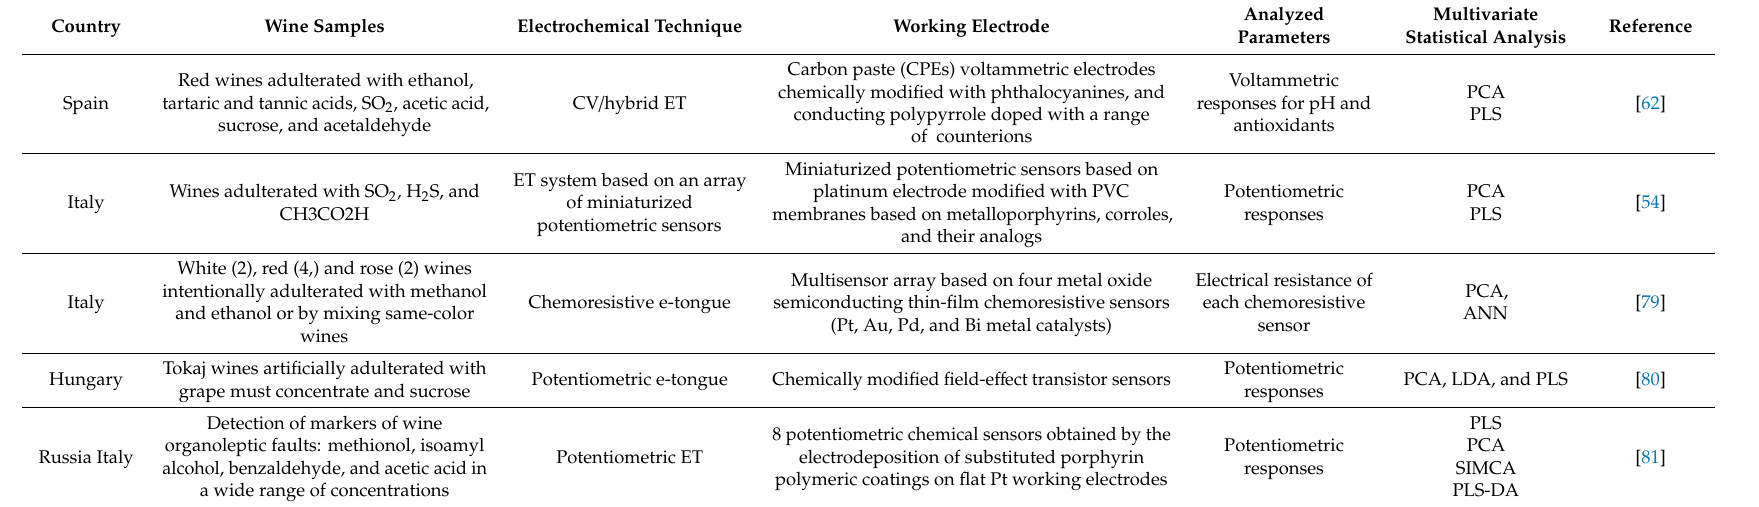
Table 3. Detection of wine frauds and